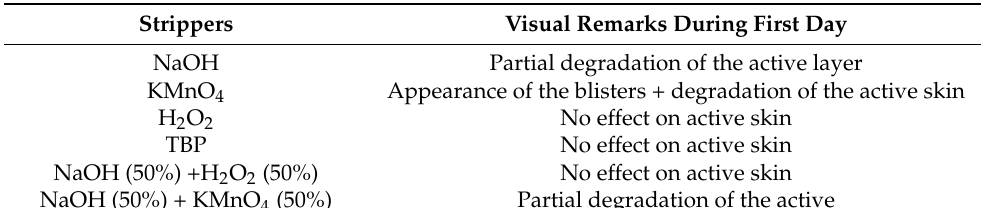
Table 2. Preliminary tests for the selection of the stripping agent.